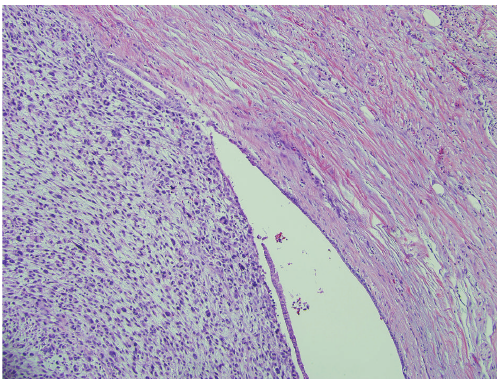
Figure 1: Low power view of the tumor showing the expansion of the duct wall with dilation of the lumen (H & E 100x).